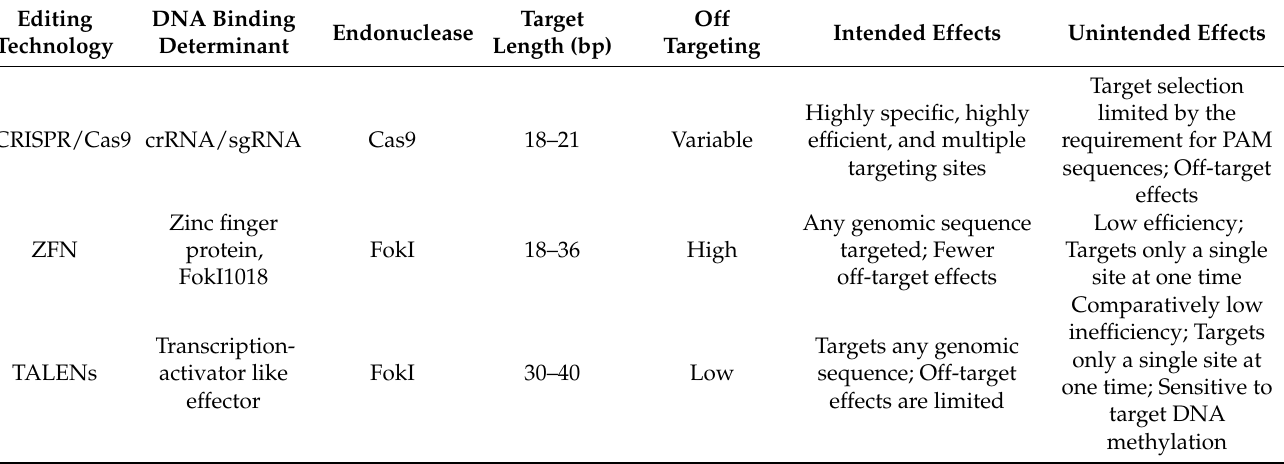
Table 1. Comparison of CRISPER/Cas9 with ZFN and